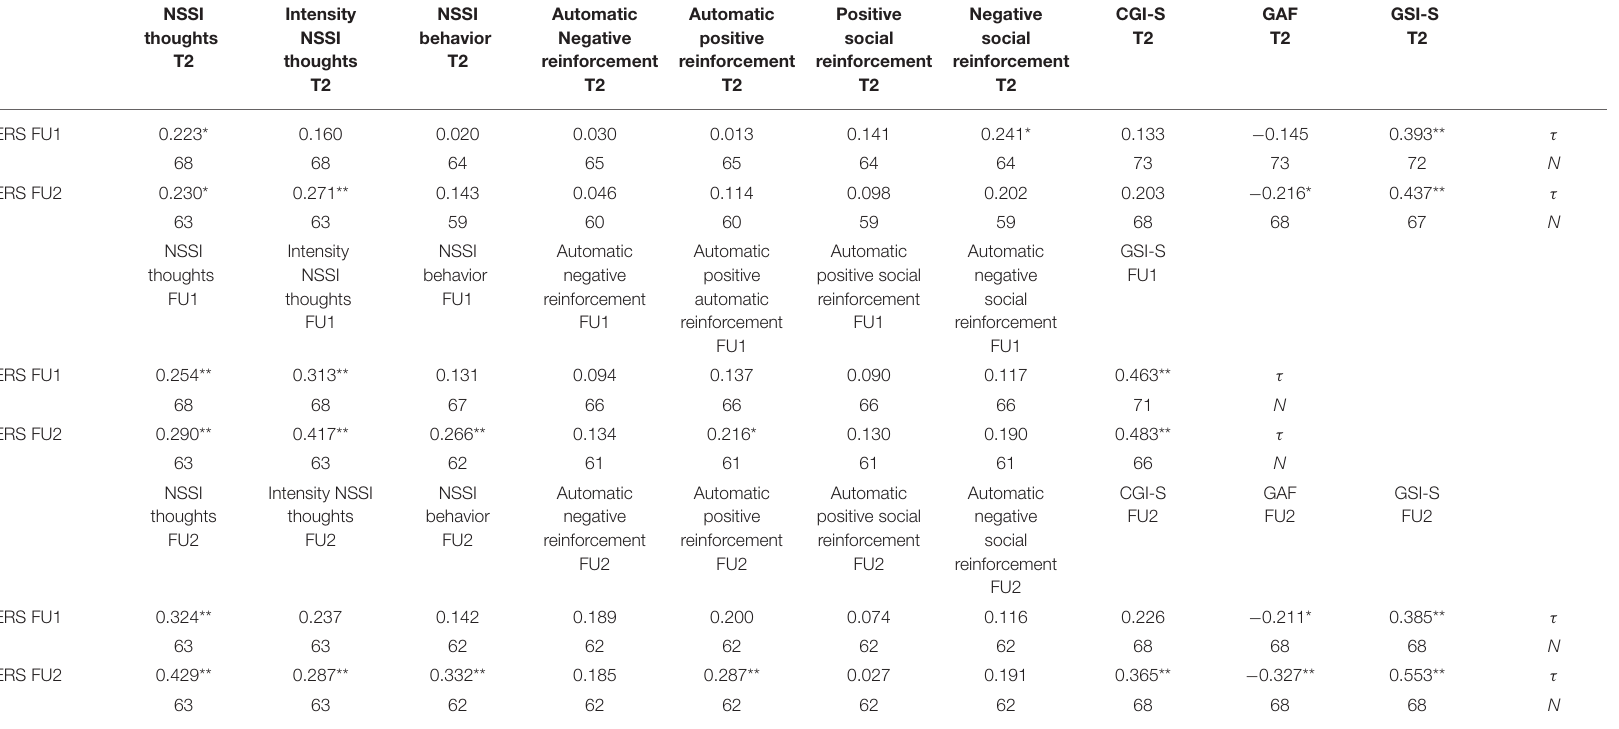
TABLE 2 | Overview of Kendall’s τ correlations between the ERS at FU1 and FU2 and other main variables across the time points T2, FU1 and FU2.